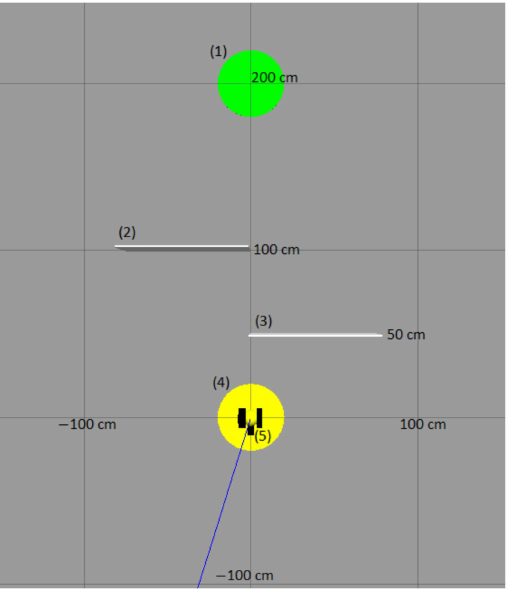
Figure 11. Simulated scenario with two obstacles: (1) goal, (2, 3) obstacles, (4) home, and (5) robot. The physical implementation of this scenario is shown in Figure